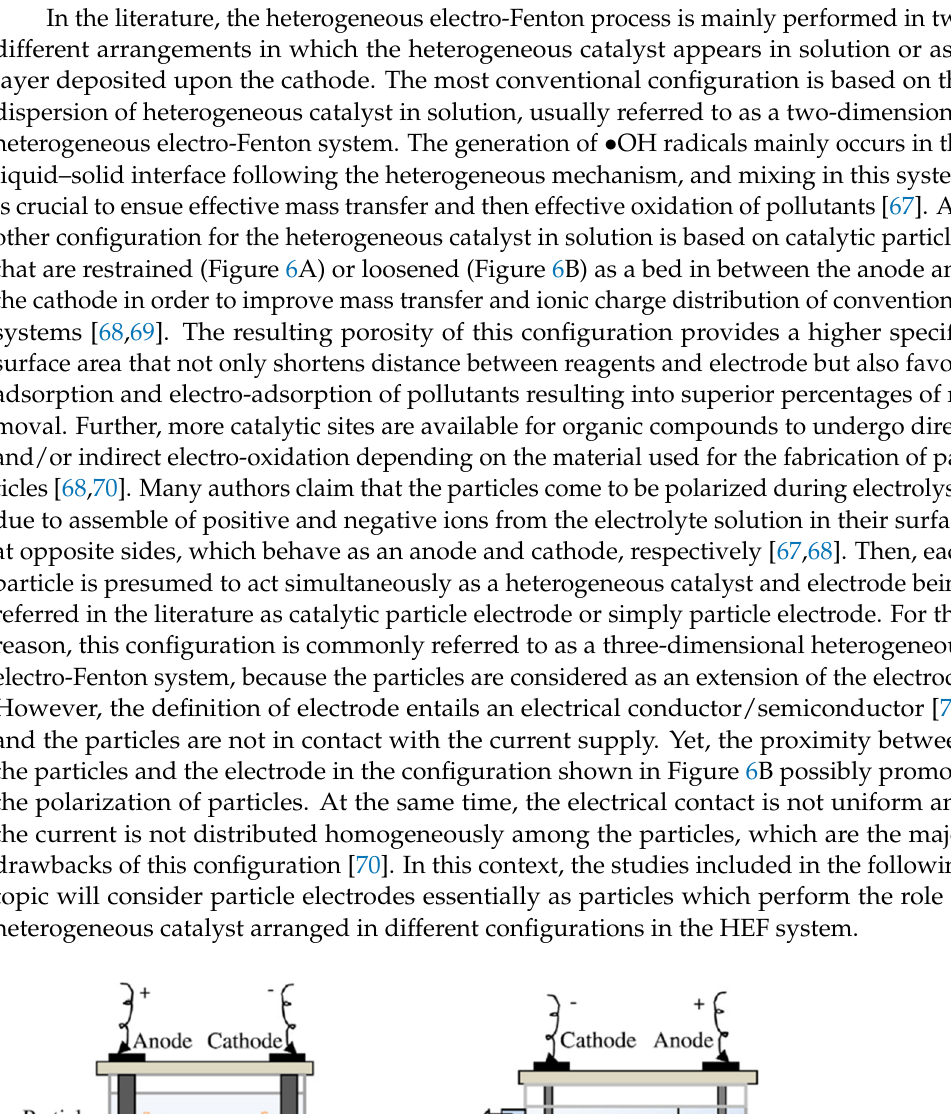
( B ) Figure 7. Scheme of three-dimensional electrochemical reactor using kaolin impregnated with ( A ) Fe 2 (MoO 4 ) 3 [69] ( B ) α -Fe 2 O 3 and CuO [70] as a heterogeneous catalyst for removal of dye molecules along with the proposed pseudo-heterogeneous mechanism for degradation of pollutants. Re- printed from [69,70] with permission from Elsevier (License Numbers 5172360390748 and 5172360545687).